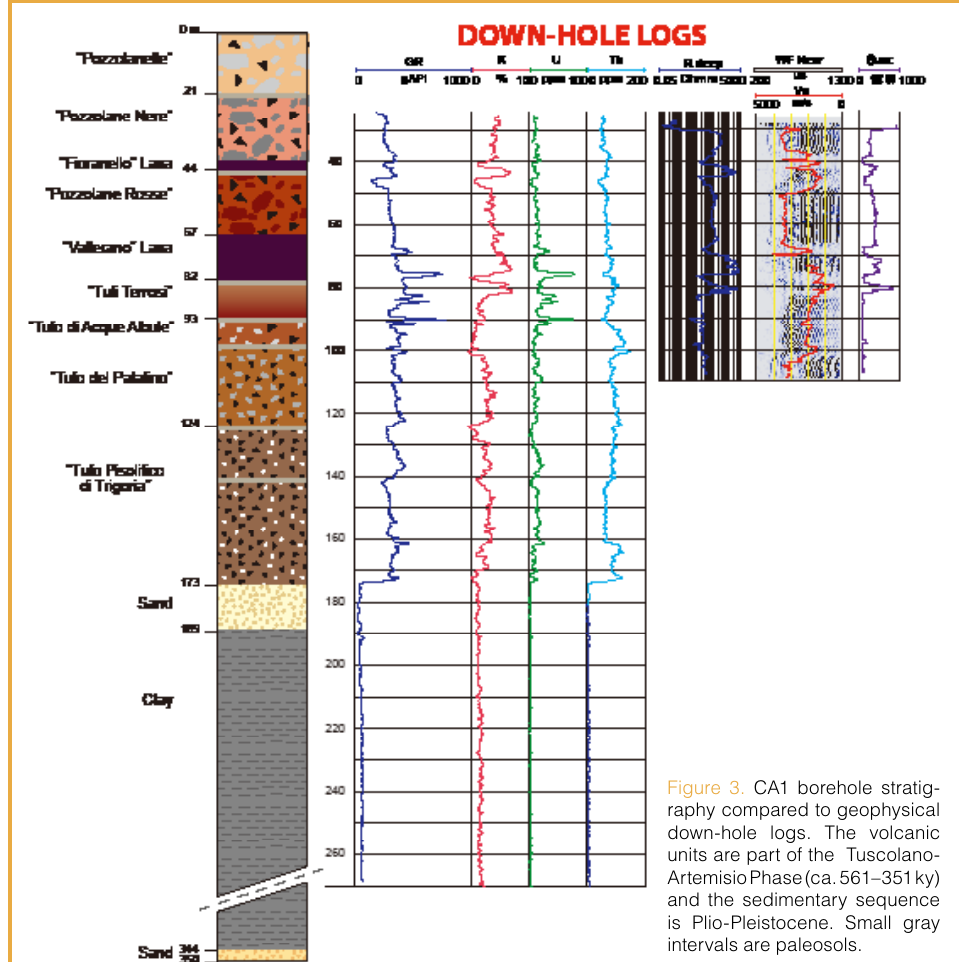
Figure 3. CA1 borehole stratig- raphy compared to geophysical down-hole logs. The volcanic units are part of the Tuscolano- Artemisio Phase (ca. 561–351 ky) and the sedimentary sequence is Plio-Pleistocene. Small gray intervals are